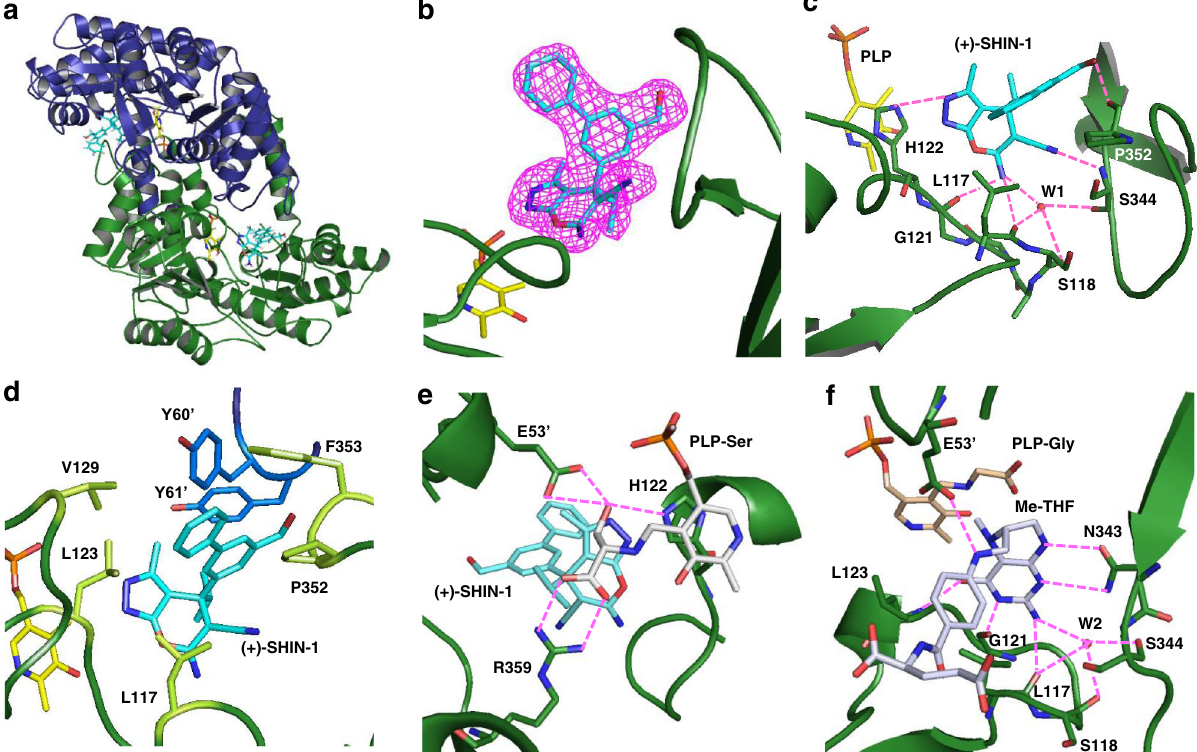
Fig. 5 Crystal structure of the efmSHMT/( + )-SHIN-1 complex. a Cartoon representation of the efm SHMT dimer. Green (chain A) and blue (chain B) cartoon structures are efm SHMT monomers. Yellow-coloured stick representation structures are PLP, whereas cyan-coloured stick representation structures are ( + )-SHIN-1. b Electron density map of ( + )-SHIN-1. The Fo – Fc map of ( + )-SHIN-1 is contoured at 3.0 s. c Polar interaction between efm SHMT and ( + )-SHIN-1. Magenta dotted lines are hydrogen bonds or polar interactions. Exocyclic amine and hydroxy groups in ( + )-SHIN-1 form hydrogen bonds with the mainchain of G121, L117 and P352. The exocyclic amine group also forms water (W1)-mediated hydrogen bonds with S344, L117, and S118. The pyrazole moiety interacts with the H122 side chain via hydrogen bonding. The exocyclic cyano group also forms polar interactions with the S344 main chain. d Non-polar interactions between efm SHMT and ( + )-SHIN-1. The biphenyl moiety in ( + )-SHIN-1 interacts hydrophobically with L117, L123, V129, P352 and F353 in chain A. The biphenyl moiety also interacts with Y60 ’ and Y61 ’ in chain B. e Ser bound to PLP hydrogen bonds with H122 and R359 in chain A, and E53 ’ in chain B. f Polar interactions between efm SHMT and Me-THF. Me-THF interacts directly with L117, G121, L123 and N342 in chain A and E53 ′ in chain B. The exocyclic amine group also forms water (W2)-mediated hydrogen bonds with S344, L117 and